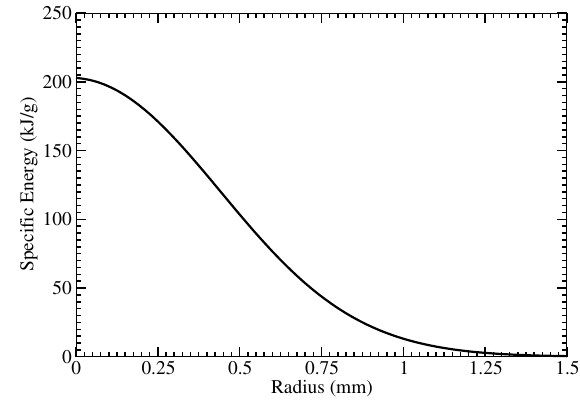
FIG. 16. Specific energy deposition vs radius at t (cid:3) 20 ns corresponding to the case shown in Fig.